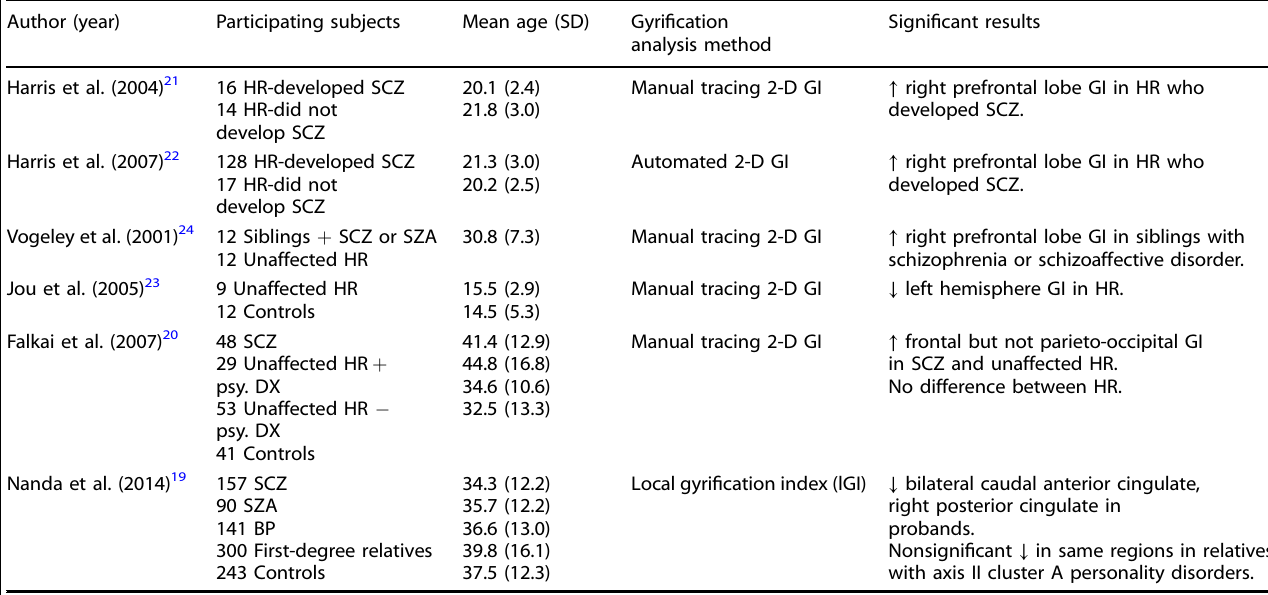
Table 1. Cross-sectional gyri fi cation studies in unaffected relatives of patients with schizophrenia. Author